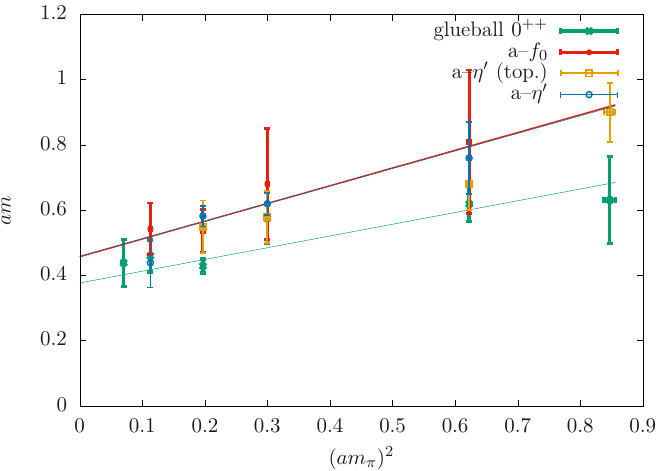
Figure 6. The masses of the different bosonic particles (singlet scalar and pseudoscalar mesons) in comparison to the glueball mass at β = 5 . 5. a– η ′ (top.) indicates the pseudoscalar meson mass obtained from the topological charge density